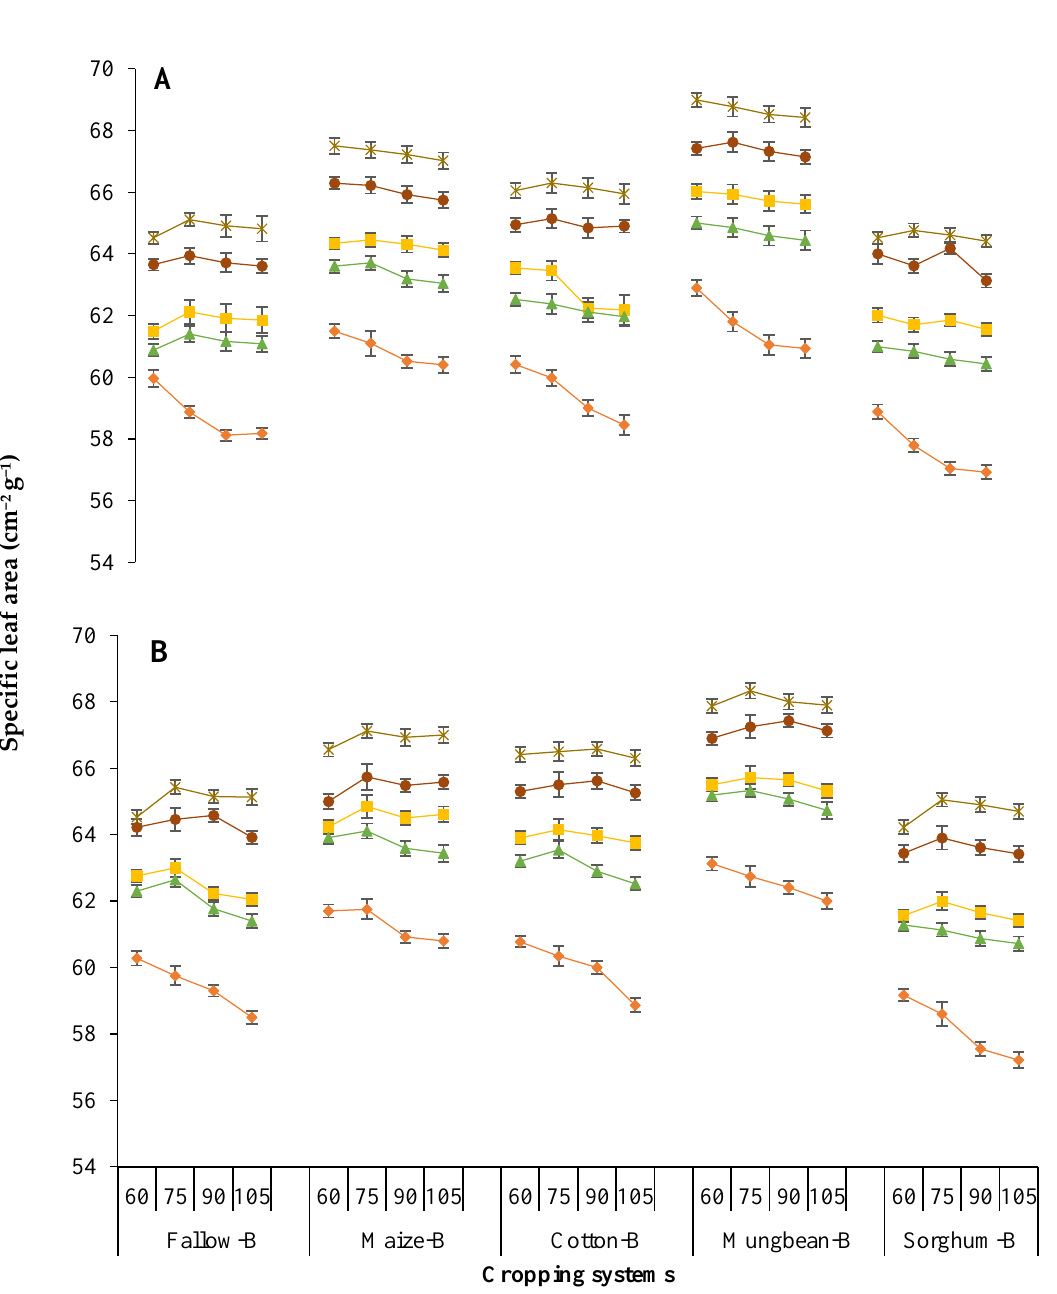
Figure 6. Interactive effect of tillage systems and barley-based cropping systems on specific leaf area (cm-2g-1) of bar- ley during 2017–2018 ( A ) and 2018–2019 ( B ) ± S.E. In the legend, Fallow-B = Fallow-barley, Maize-B = Maize-barley, Cotton-B = Cotton-barley, Mungbean-B = Mungbean-barley and Sorghum-B =